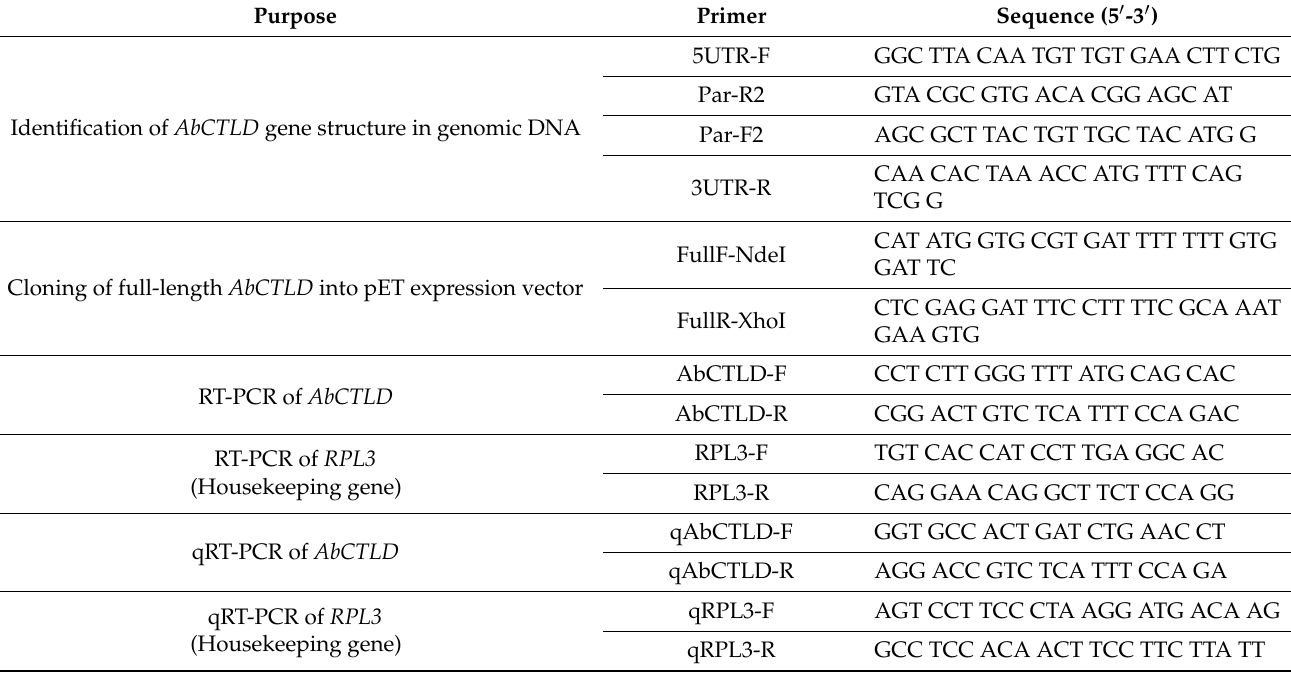
Table 1. List of primers used to identify and analyze